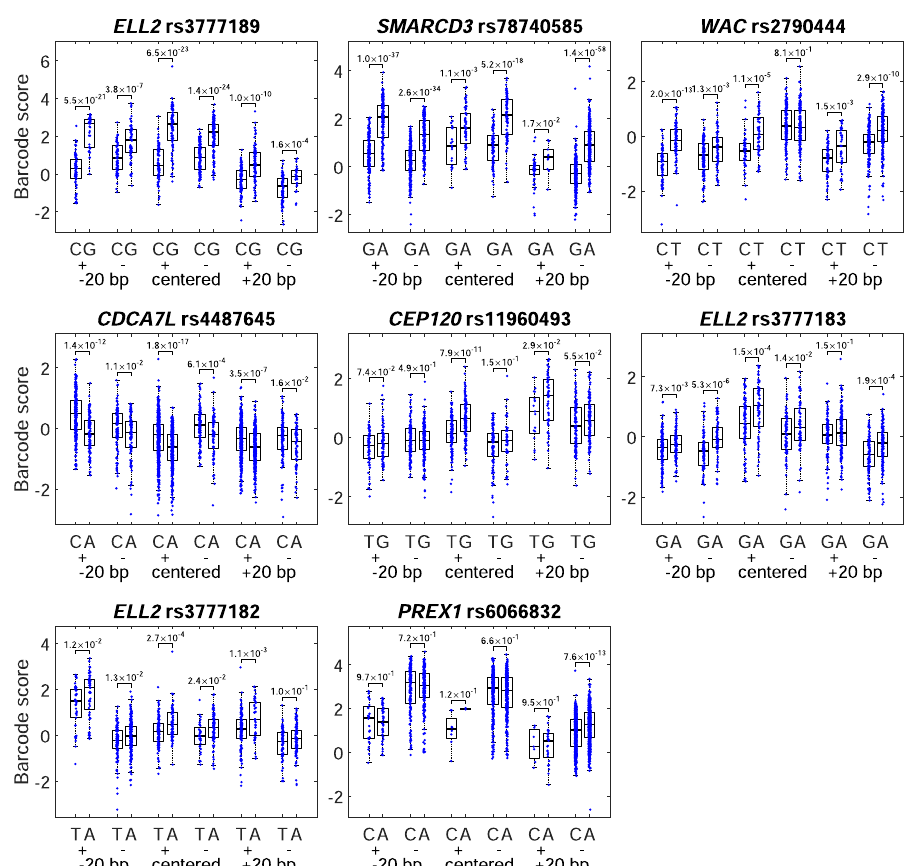
Fig. 3 MPRA data for identi fi ed variants. Individual MPRA barcode activity estimates for the eight variants in Table 1 also showed concordant plasma cell cis -eQTLs. The data have been grouped by allele (reference allele to the left; an alternative to the right), DNA strand ( + or − ), and sliding window (variant at − 20, 0, or + 20 bp from the center of the 120-bp oligonucleotide representing the genomic context). Blue dots represent individual barcode activity estimates. The bottom, middle, and top of each box plot represent the 25th, 50th, and 75th percentiles. The whiskers represent the non-outlier minimum and maximum values, located at 1.5 times the interquartile range from the bottom and top of the box, respectively. The numbers by the brackets are P values for the two-sided Student ’ s t -test. The luciferase validation data for these eight variants are shown in Supplementary Fig. 4. The individual barcode activity estimates for MOLP8 cells, as well as individual barcode activity estimates for the other variants in Table 1, are shown in Supplementary Fig.